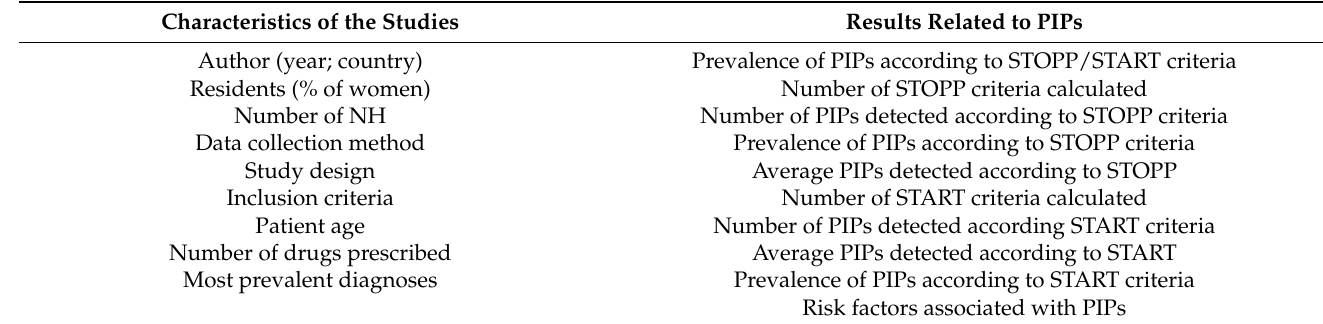
Table 1. Variables obtained in the selected